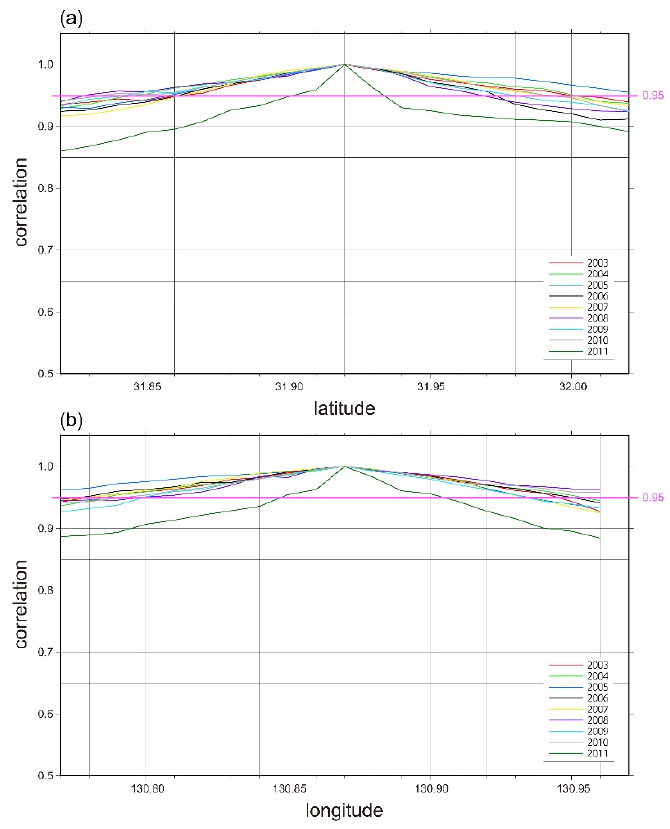
Figure 3. Range correlations from the summit crater of Shinmoedake along ( a ) latitude and ( b ) longitude each year. Colors indicate the year. Green line corresponds to the year of 2011 when is the volcanically active year.